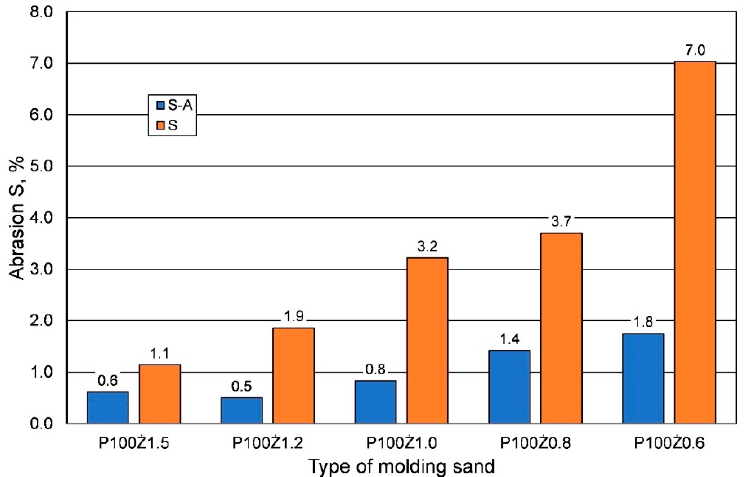
Figure 6. Abrasion S of the hardened sand (after 24 h) prepared on the basis of fresh chromite sand, depending on weather conditions, for different amounts of added binder.